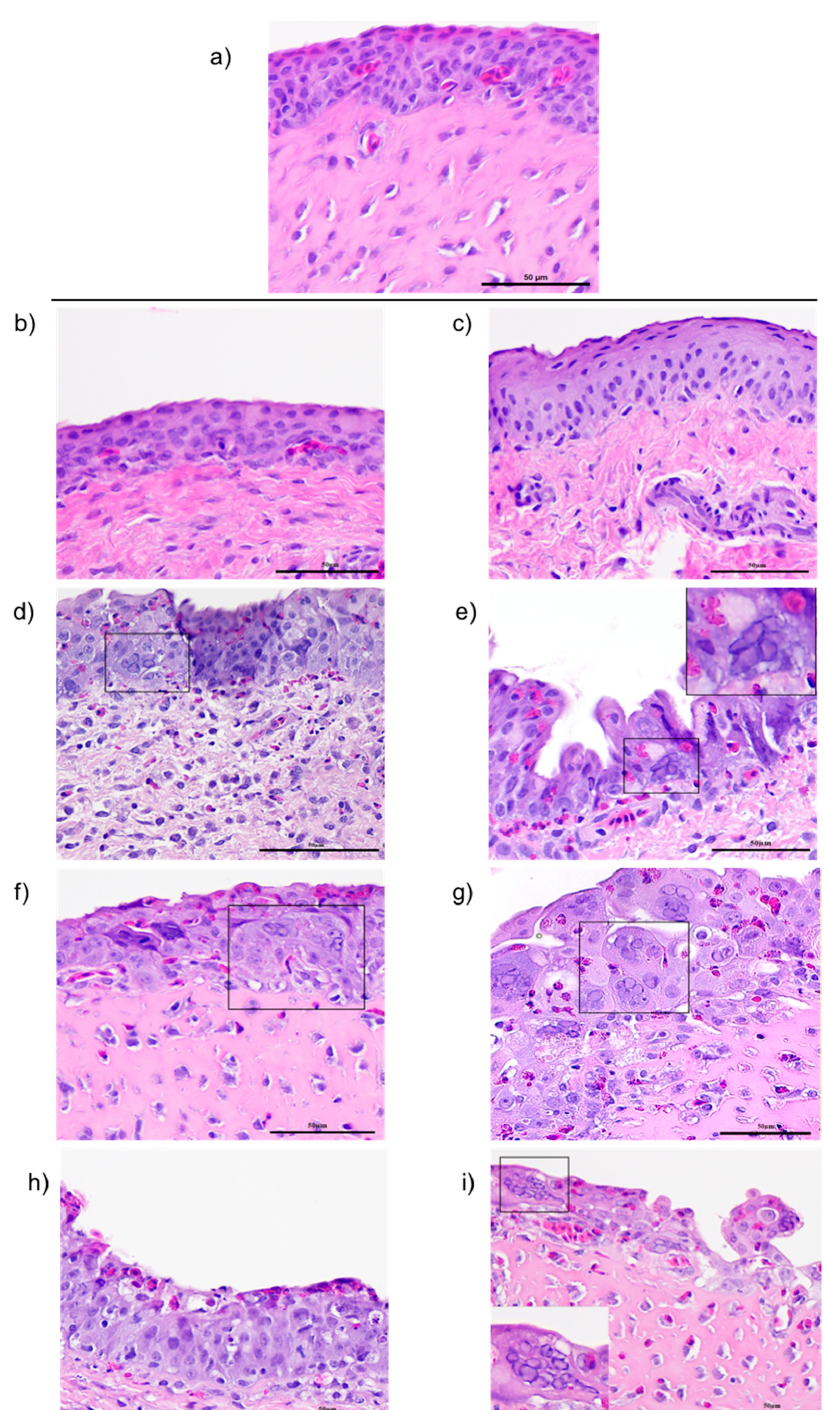
Figure 3. Photomicrographs of conjunctiva epithelium collected from the CEO vaccine strain- and virulent 63140 strain-inoculated chickens. Conjunctiva sections from the mock-inoculated group ( a ), from CEO vaccine strain-inoculated chickens collected at 1 ( b ), 3 ( d ), 5 ( f ), and 7 ( h ) dpi and from 63140-inoculated chickens collected at 1 ( c ), 3 ( e ), 5 ( g ), and 7 ( i ) days post-inoculation. Evidence of infectious laryngotracheitis virus (ILTV) lytic replication; syncytia cell formation with eosinophilic intranuclear inclusion bodies are indicated in insets within the